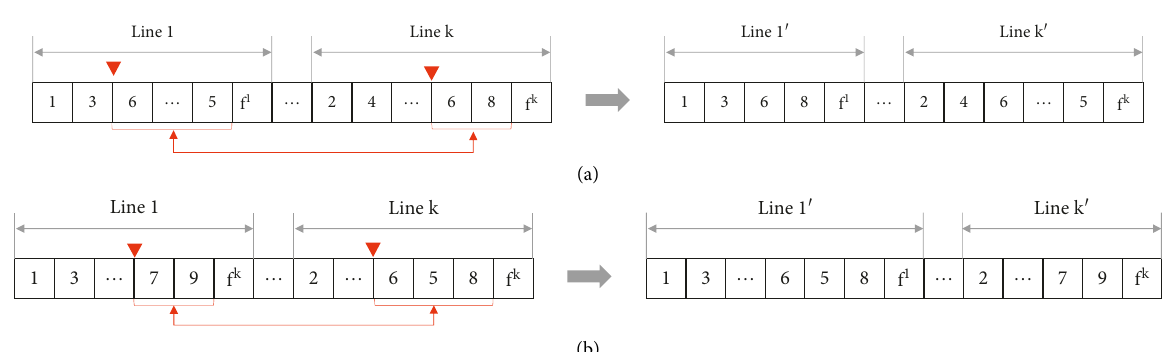
Figure 4: Station crossover. (a) With. (b) Without the same station.